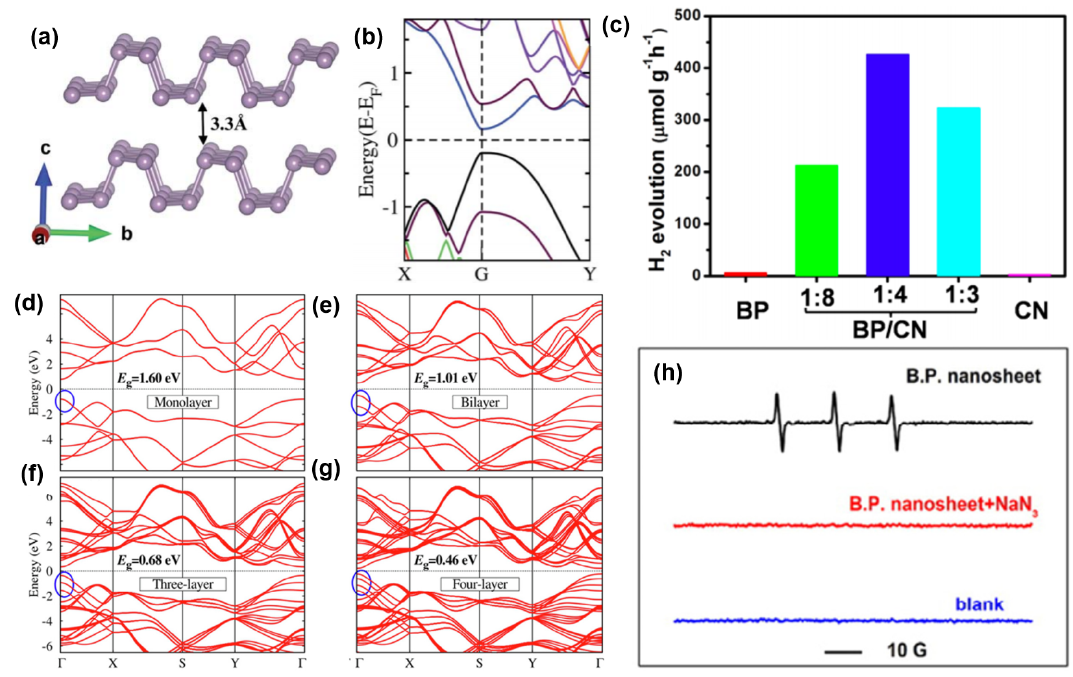
Figure 18. ( a ) Schematic crystal structure of the AA bilayer black phosphorus (BP) and ( b ) the corresponding band structure. Reproduced with permission from reference [255]. Copyright 2017, American Chemical Society. ( c ) Cycle stability test of BP/CN photocatalyst for H 2 evolution under visible light irradiation. Reproduced with permission from reference [254]. Copyright 2014, American Physical Society. ( d – g ) Band structures BP with different thicknesses calculated using the GF